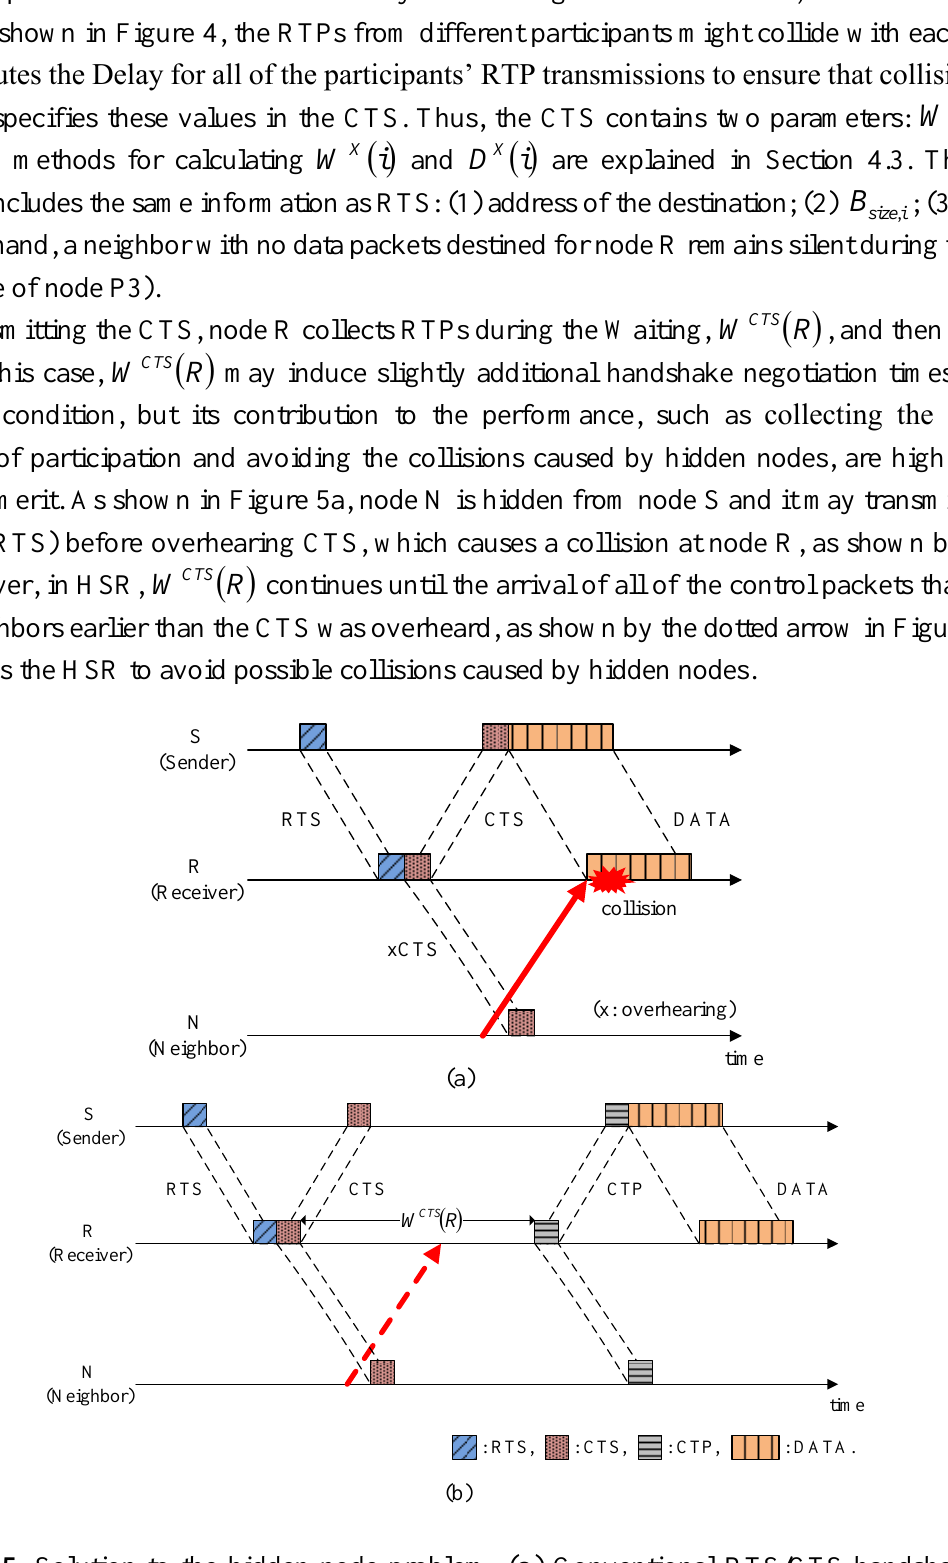
Figure 5. Solution to the hidden-node problem: ( a ) Conventional RTS/CTS handshaking protocol; and ( b ) HSR